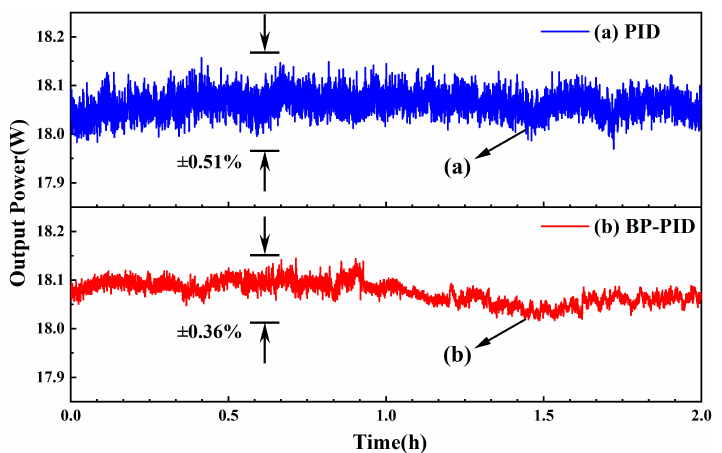
Figure 7. Comparison of output power and its stability between traditional PID control and BP neural network PID control. The blue line (a) is traditional PID control and the red line (b) is BP neural network PID control. Test time was 2